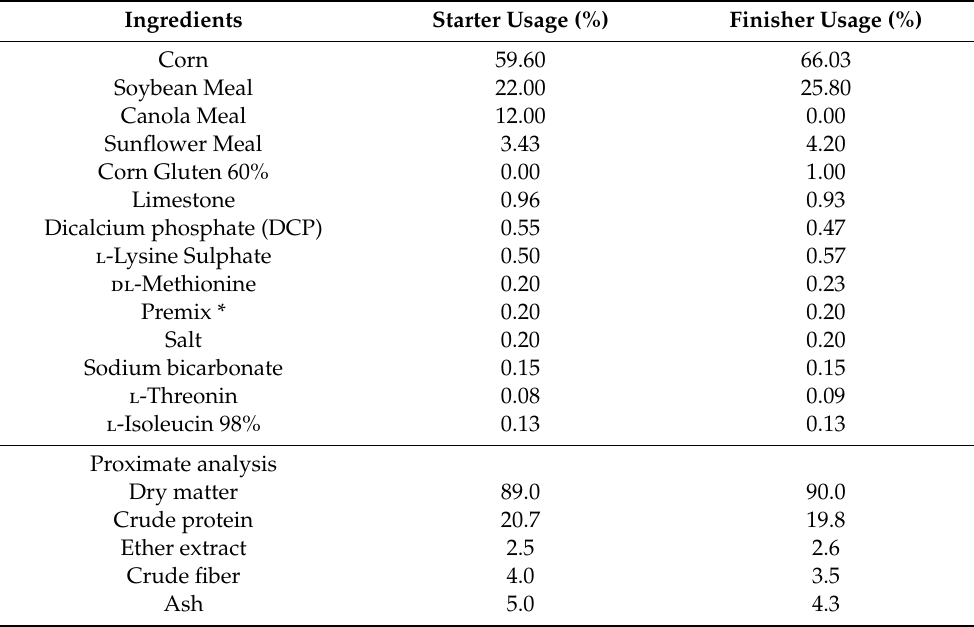
Table 1. Basal diets of broiler starter and broiler